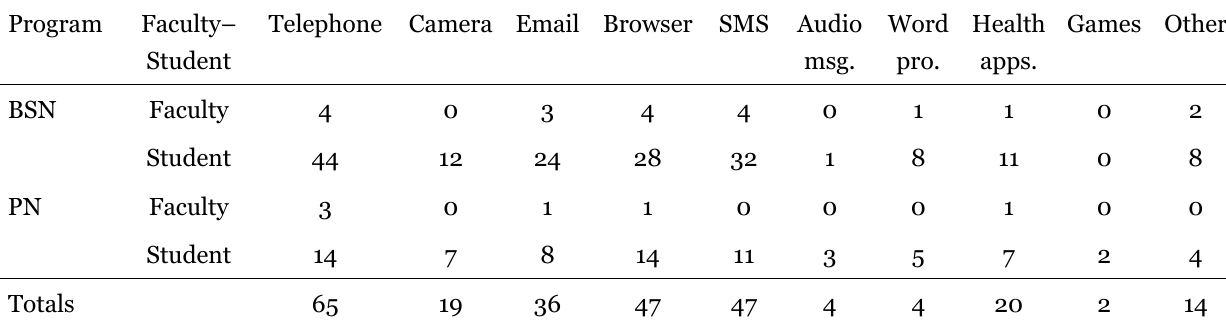
Mobile Features Used in Nursing Education by